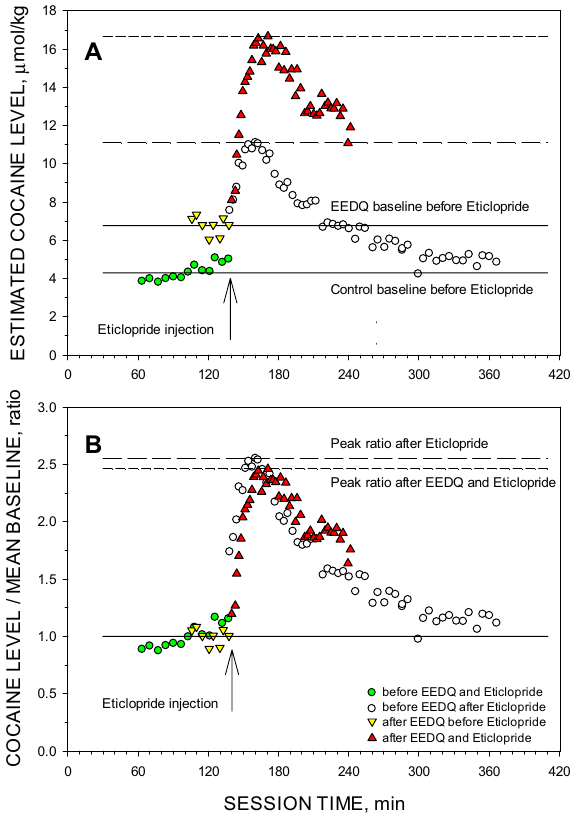
Figure 5. The effect of an EEDQ injection on the potency of eticlopride to elevate the cocaine satiety threshold during cocaine self-administration. The panels show two representative sessions of cocaine self-administration in the same animal before and after EEDQ injection. Panel ( A ) shows the calculated cocaine concentration over time. Panel ( B ) shows ratios of cocaine levels at the time of injection to the mean of corresponding baseline levels. Circles represent concentrations before (green) and after (open circles) eticlopride injection in the absence of EEDQ. Triangles represent cocaine concentrations before (yellow) and after (red) eticlopride injection in the presence of EEDQ. Solid lines show mean baselines cocaine levels one day before EEDQ injection (4.3 μmol/kg) and 40 h after EEDQ injection (6.8 μmol/kg). Dash lines show the maximal cocaine level after eticlopride (20 nmol/kg i.v.) injection on the day before (11.1 μmol/kg, long-dash) and after EEDQ injection (16.7 μmol/kg, short-dash). The ratios of the estimated peak concentration to the corresponding baselines were 2.6 and 2.5,